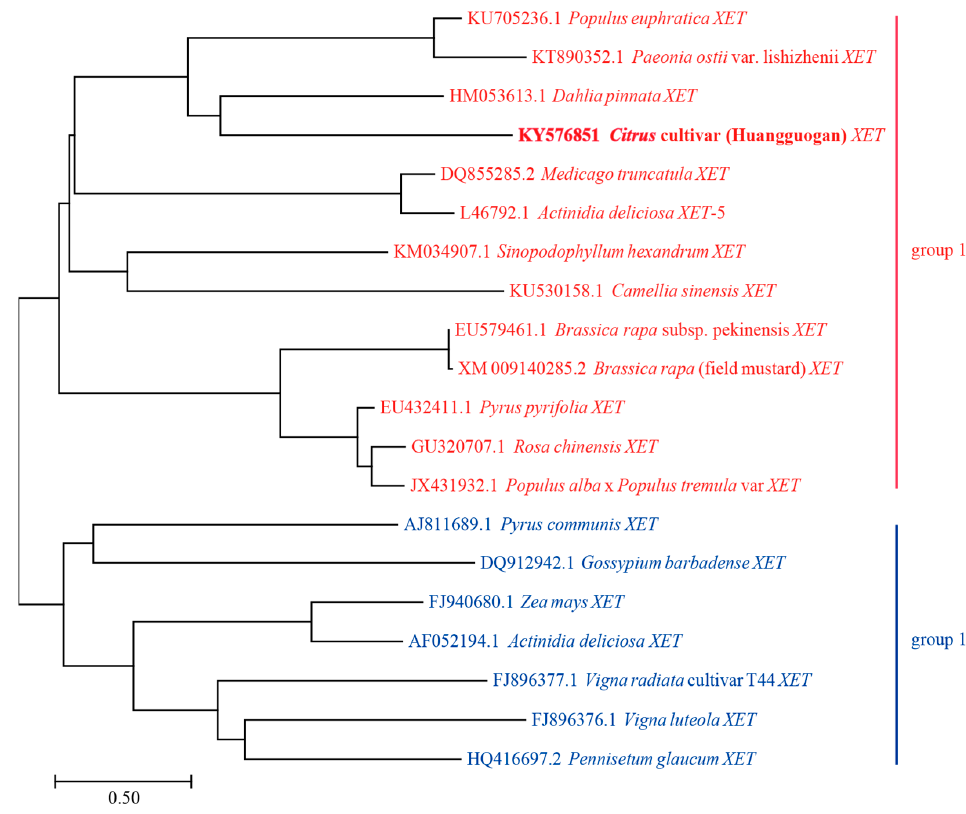
Figure 1. Phylogenetic tree based on the XET coding sequences. The tree was generated by the neighbor-joining (NJ) method using the MEGA 7.0.12 program. The bootstraps values were calculated with 1000 replicates. Table 1. Accession numbers and characteristics of the analyzed XET coding sequences.